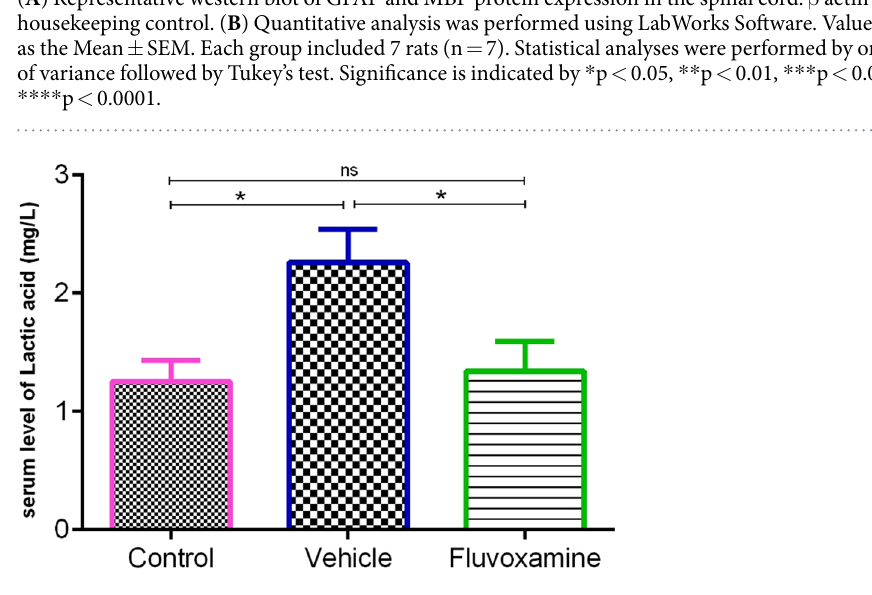
Figure 11. Measurement of lactate levels in serum samples using HPLC. Induction of EAE caused an increase in lactate concentrations, however, administration of fluvoxamine reverted the serum levels of lactate back to normal; Data are expressed as Mean ±